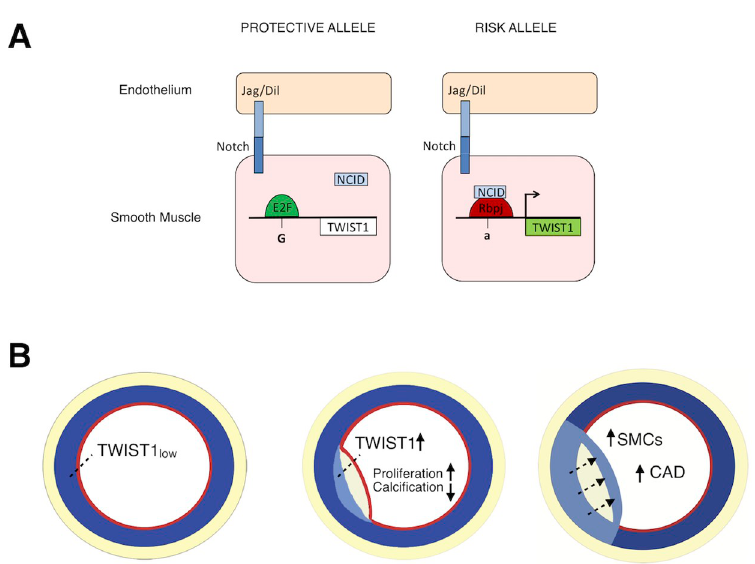
Fig 6. From SNP to phenotype. A) Proposed mechanism of transcriptional regulation at the rs2107595 locus in the vessel wall. The major allele (left) is predicted to bind E2F transcription factors which are unresponsive to Notch signaling. The minor allele (right) creates a consensus RBPJ binding site which promotes TWIST1 gene transcription. B) The effect of TWIST1 protein on cardiovascular risk. In normal arteries, TWIST1 expression is low in fully differentiated smooth muscle cells of the tunica media (left). During early atherosclerosis (middle), there is increased TWIST1 expression in SMCs. This favors a de-differentiated SMC phenotype which increases SMC proliferation and increases coronary artery disease